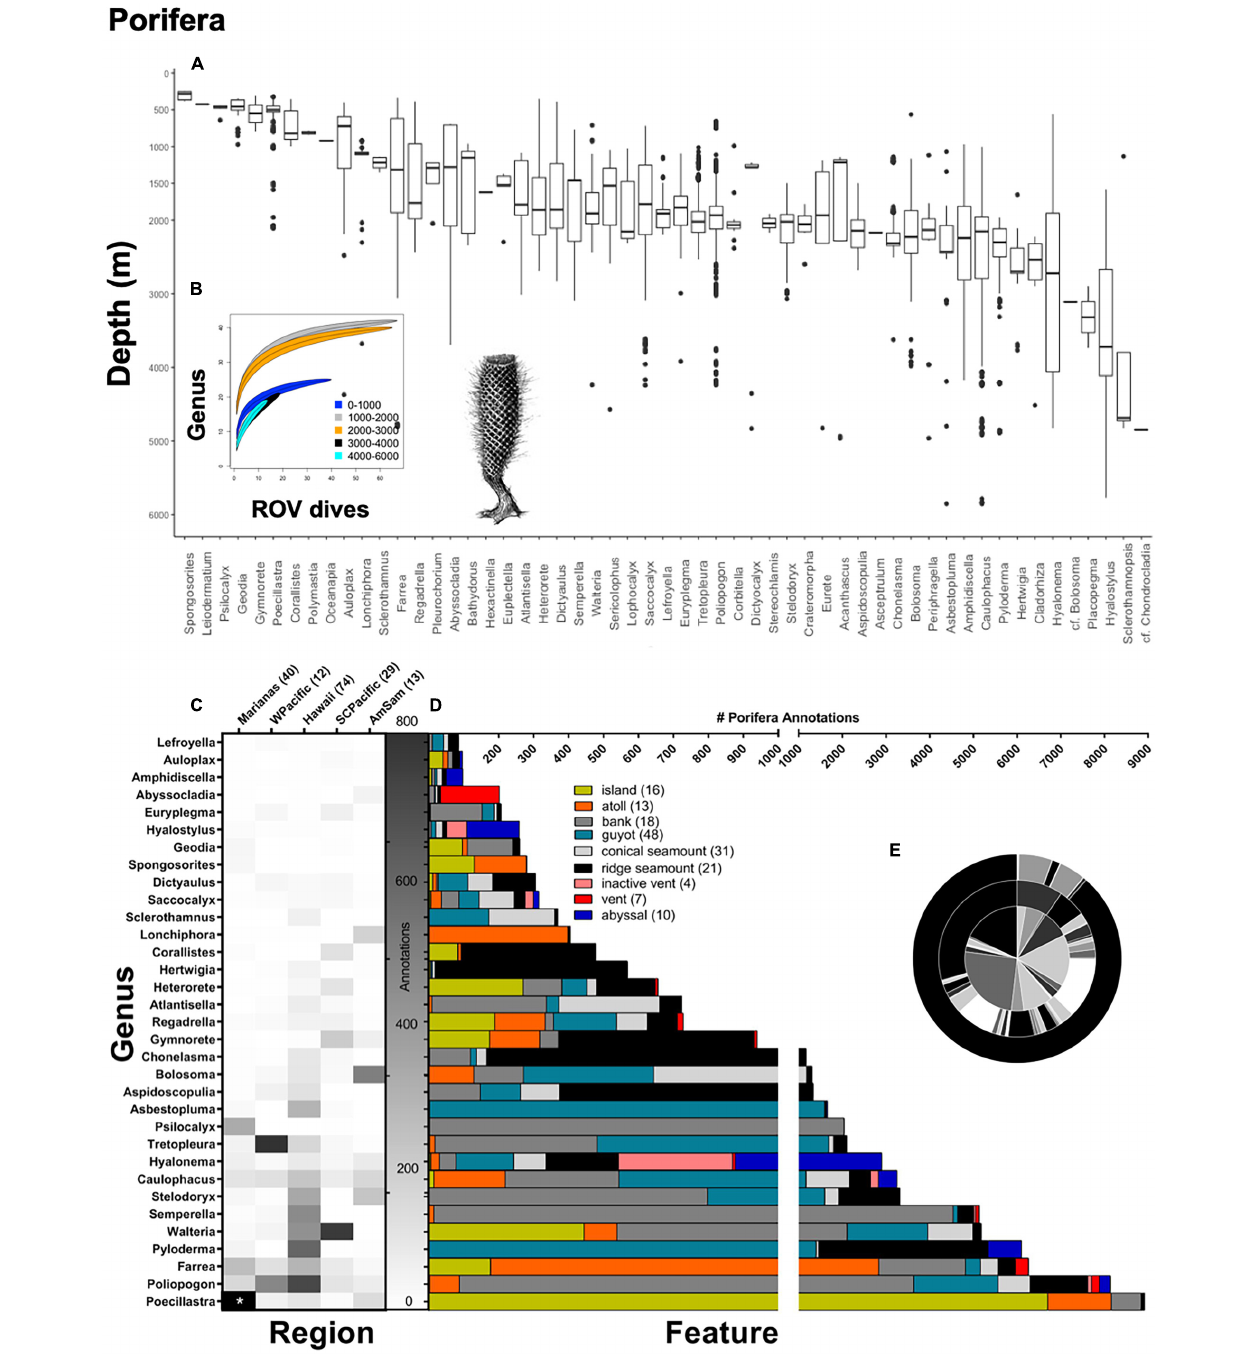
FIGURE 5 | Top panel: (A) Poriferan annotations at the genus-level demarcated by depth (m). A total of 46,128 poriferan annotations were used to make box-and-whisker plots, organized from shallow to deep along the x -axis. A total of 55 poriferan genera were observed over CAPSTONE. Rarefaction curves (B) are shown for all of Porifera (55 genera), color coded by depth 0–1,000 m (blue) 1,000–2,000 m (gray), 2,000–3,000 m (orange), 3,000–4,000 m (black), and 4,000–6,000 m (cyan). Lines are drawn with a 95% confidence envelope. Bottom panel: Porifera annotations representing at the genus-level demarcated by (C) geographic region and (D) geologic feature; the number of dives for both are in associated parentheses. A total of 33 poriferan taxa are shown, representing every genus where 50 observations or more were made during CAPSTONE. Starred boxes on heatmap represent abundances outside the range represented, specifically, 2,877.59 Poecillastra spp. were observed (corrected for effort) in the Marianas Region. Axis breaks by feature do not omit any data; breaks instead allocate annotation effort on different scales. (E) Nested pie chart shows overall taxonomic diversity at the family level (inner circle), genus level (middle circle), and species level (outer circle), for all poriferans annotated. Unidentified annotations are represented by the largest black bar originating at 12:00, progressing counter-clockwise.